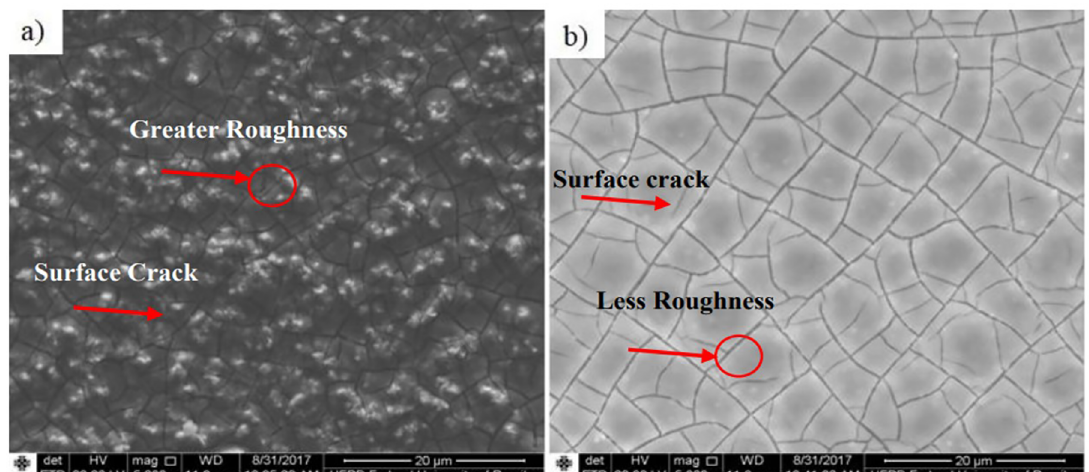
Figure 5. Micrography of (a) sample 5 and (b) sample